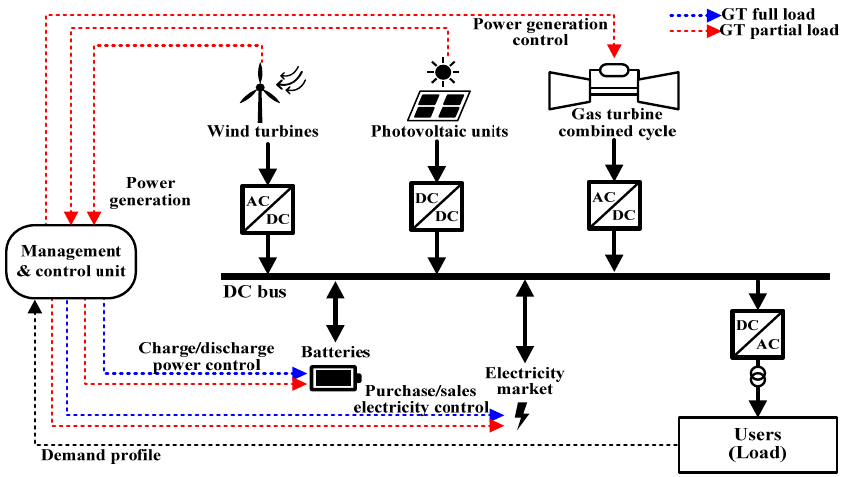
Figure 2. Conceptual diagram of distributed generation system and power supply flow. Dotted arrows indicate the power control to match the generated electricity to the demand. The black dotted line means the user’s ever-changing demand. The management and control unit receives the demand information and controls the power generation of each power source. The blue dotted lines are for when the GT operates under full load, and the red ones are for when the GT operates under partial load. When the GT operates at full load, the charge/discharge power of the batteries and the